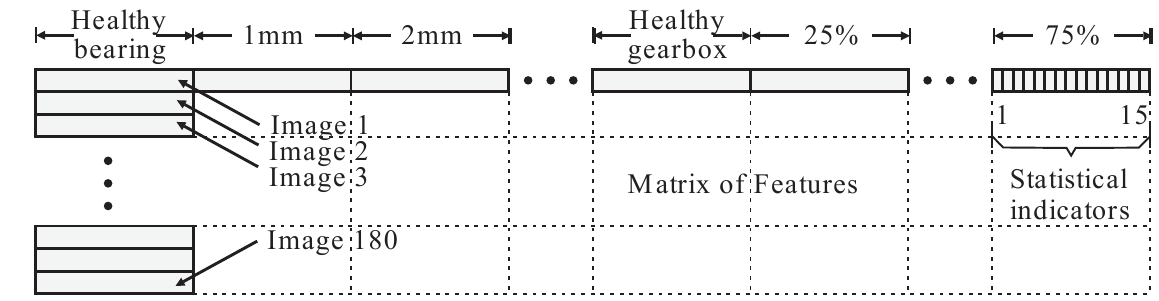
Figure 7. Matrix of features with high dimensionality.